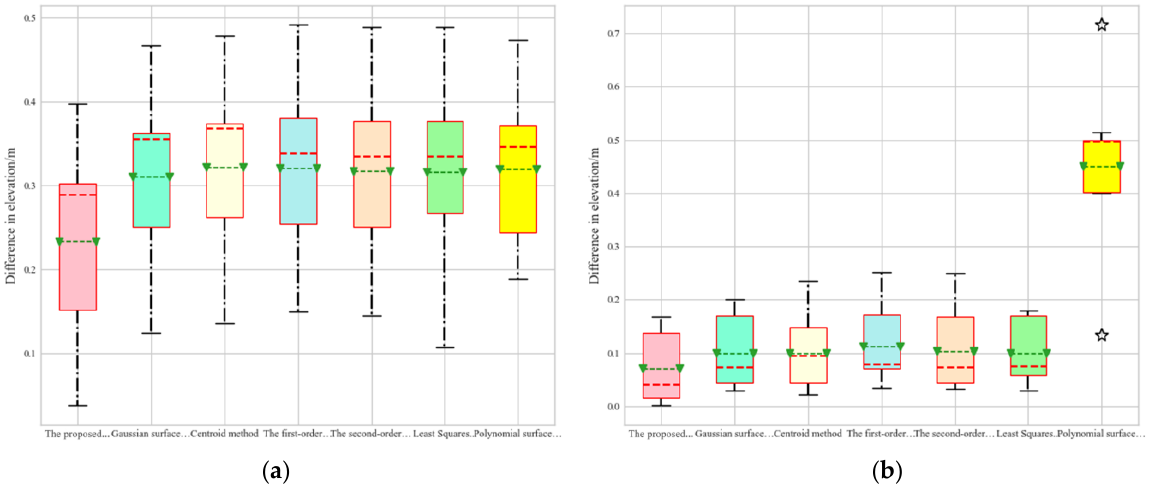
Figure 14. ( a ) Elevation accuracy verification results of laser footprints positioned using different methods for Beam 1 in 2020, ( b ) Elevation accuracy verification results of laser footprints positioned using different methods for Beam 2 (the green dotted line is the mean value of elevation difference, the red dotted line is the corresponding median, and the star is the abnormal value).